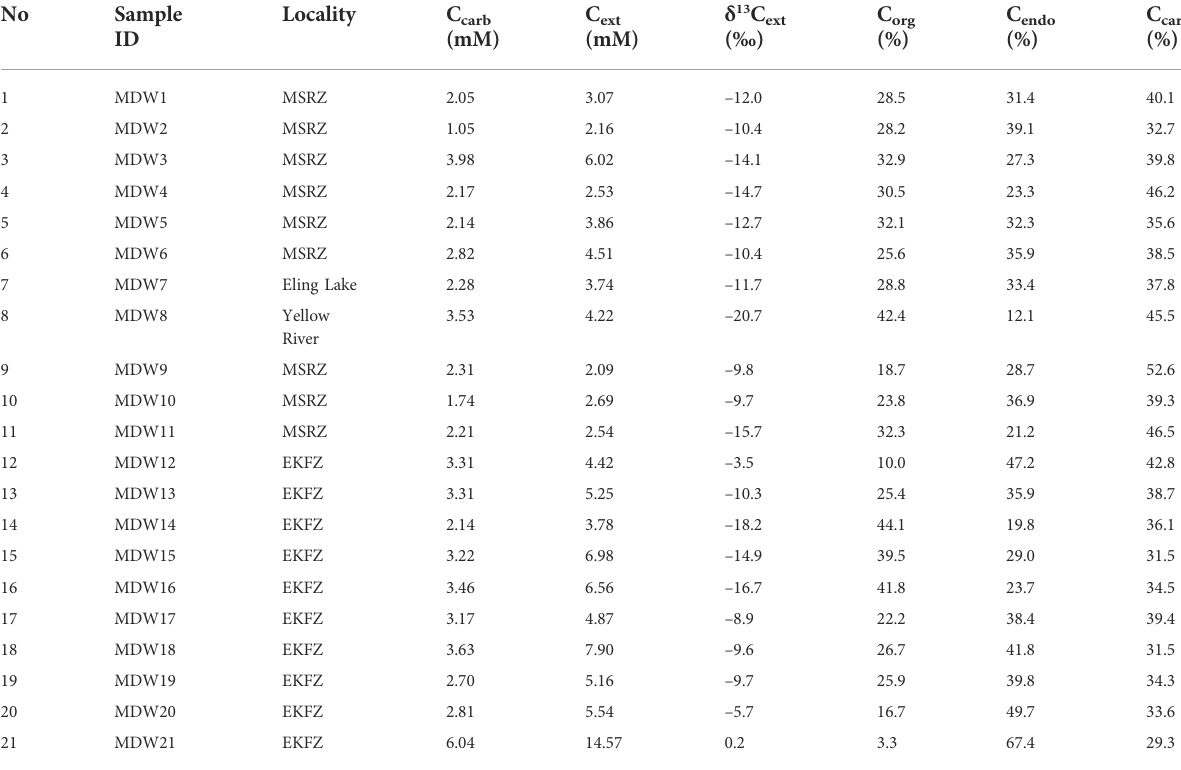
TABLE 2 Proportions of organic carbon, deeply-sourced carbon, and carbonate involved in DIC of the water